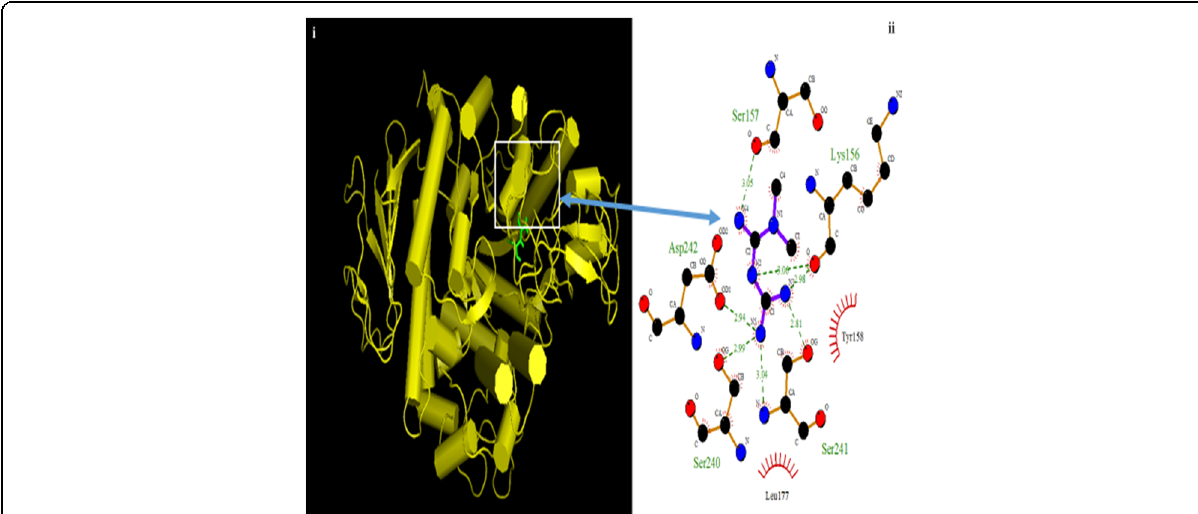
Fig. 19 The Binding pose of metformin at the active site of α -glucosidase with a binding energy of − 5.40 kcal/mole (i), and molecular interaction of metformin with amino acid residues within the active site of α -glucosidase